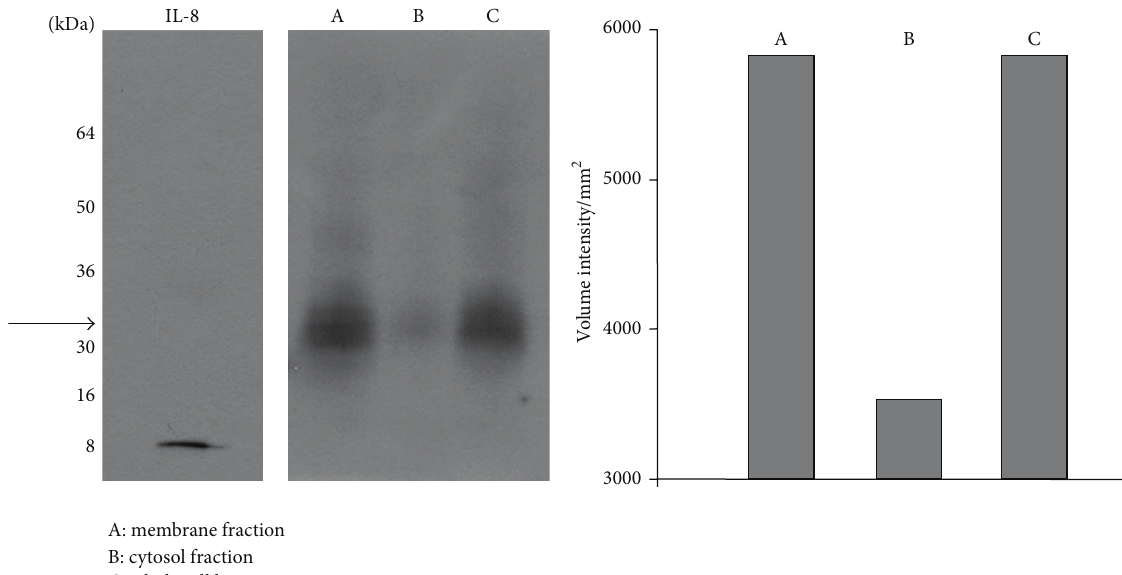
Figure 2: Binding of IL-8 to M. tb . Detection of IL-8 associated with cellular fractions of M. tb using Western Blot. The vertical bar chart depicts densitometric analysis of protein bands with Quantity One 1D Analysis Software